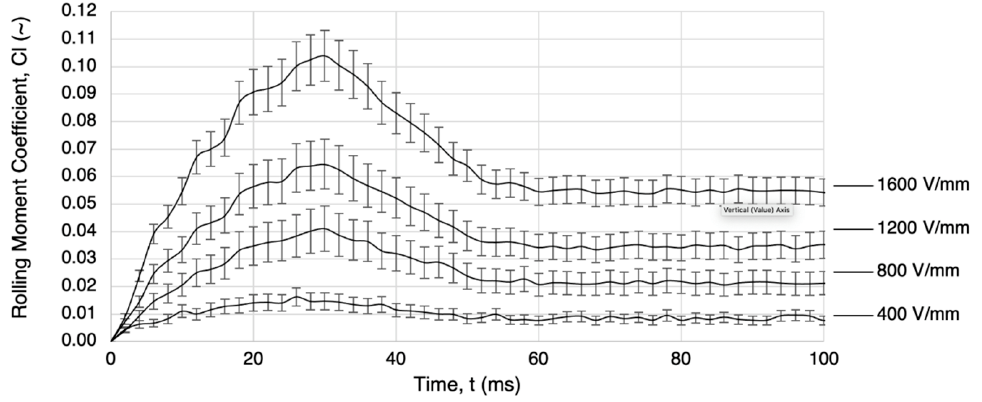
Figure 16. Rolling moment coefficient about the wing root, 120 ft/s (36.6 m/s), Rn = 191,000.